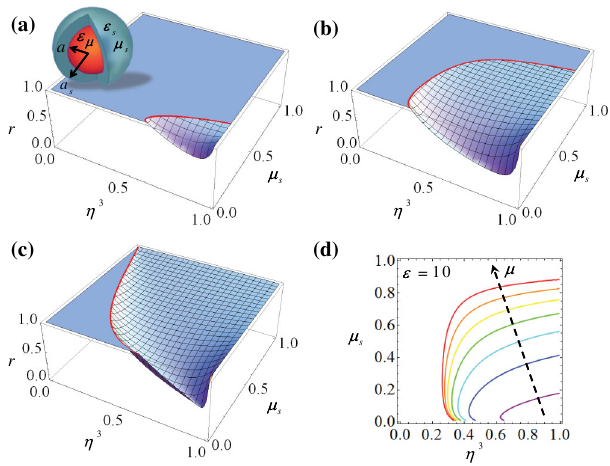
FIG. 3. A spherical object covered by a dielectric diamagnetic cloak, as depicted in the inset of (a), with 0 < (cid:4) s < 1 and " s ¼ r between uncloaked and 1 =(cid:4) s . (a)–(c) Static polarizability ratio cloaked scenarios, calculated through Eq. (9), as a function of the filling factor (cid:5) 3 and the relative static permeability (cid:4) s of the cloak. Three spherical objects with different material properties are considered: (a) " ¼ 10 , (cid:4) ¼ 1 , (b) " ¼ 10 , (cid:4) ¼ 5 , and (c) " ¼ 1 , (cid:4) ¼ 10 . In each case, only the region where the cloak reduces the integrated scattering, i.e., r < 1 , is shown. The thick red curves indicate where r ¼ 1 , delimiting the region of interest. (d) This boundary r ¼ 1 is evaluated, varying the object permeability (cid:4) , for " ¼ 10 . From bottom to top, (cid:4) changes from 1 to 7 with unitary steps. The region in which the diamagnetic cloak is effective in reducing the integrated scattering is below each